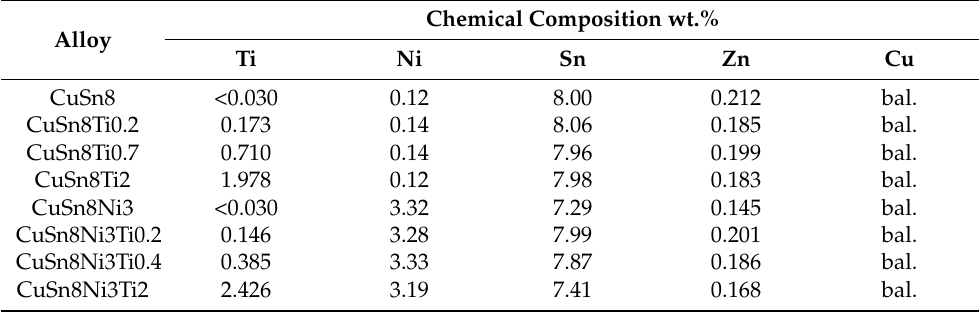
Table 1. Chemical composition (wt.%) of tin Cu-Sn alloys with additions of nickel and titanium. Chemical Composition wt.% Alloy Ti